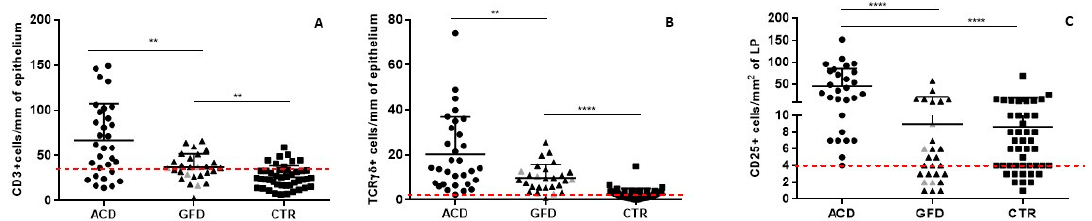
Figure 2. Immunohistochemical parameters in different patients group. ( A ) CD3+ cells/mm of intesti- nal epithelium. ( B ) TCR γδ + cells/mm of intestinal epithelium. ( C ) CD25+ cells/mm 2 of intestinal lamina propria. Grey dots represent patients on a gluten free diet with a persistently positive CD- serology. Dashed horizontal line represents cut-off limits of normality for each immunohistochemical parameter. ACD: atrophic celiac disease; GFD: gluten free diet; CTR: controls. *: level of